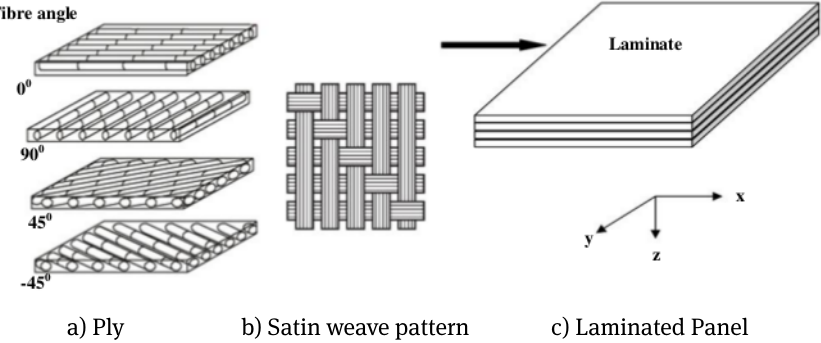
Figure 1: Schematic of symmetric 8-Ply laminated panel.